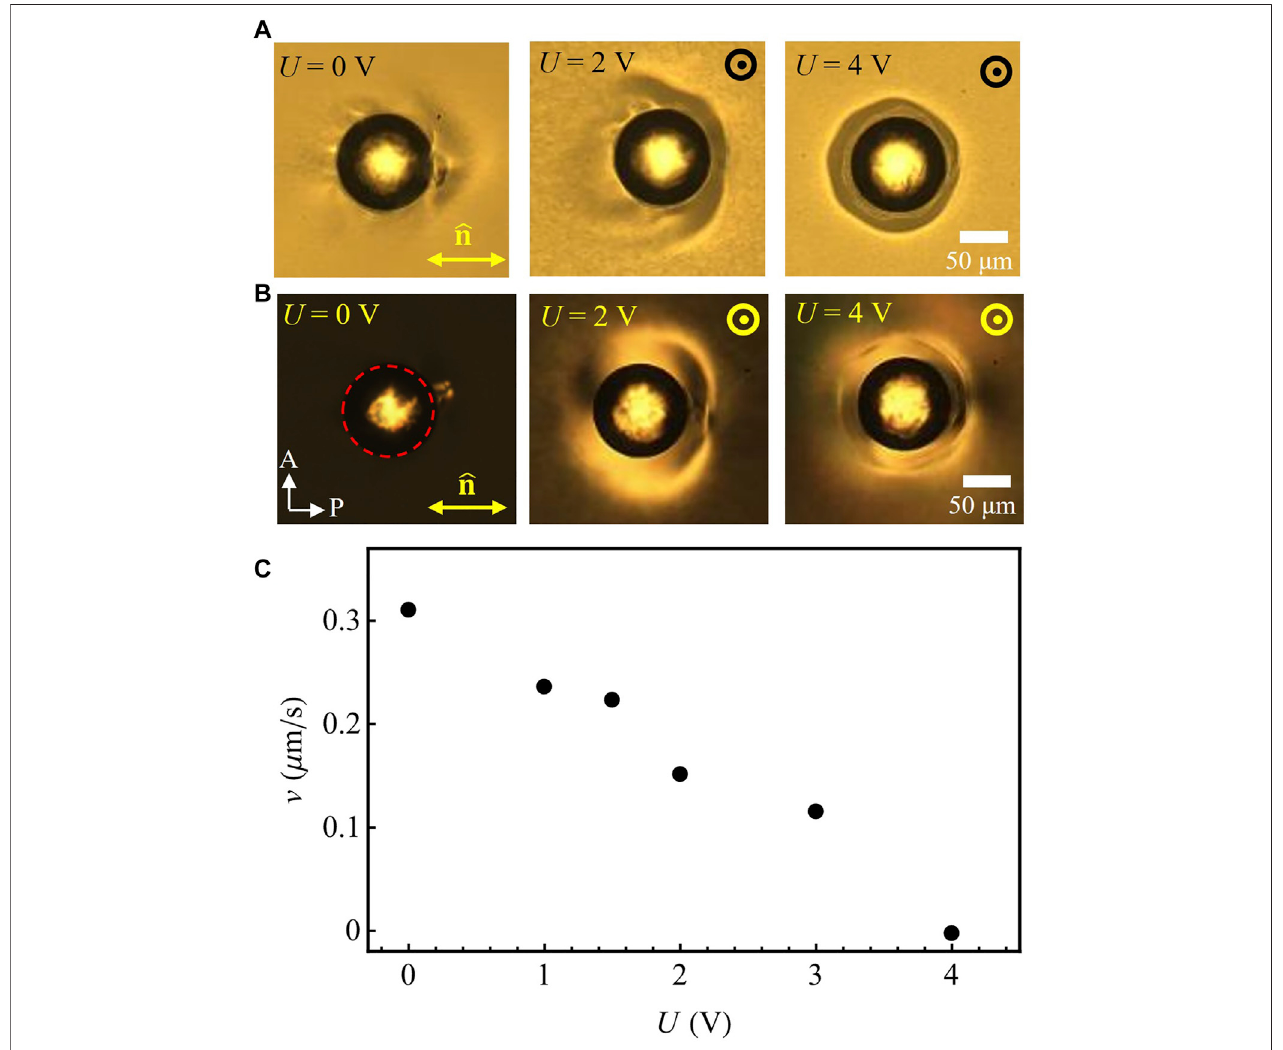
FIGURE 5| Polarizing microscopyobservations in (A) bright fi eld, and (B) with crossed polarizers ofactive droplets at different applied voltages. The fi eld direction is normal to the cell. f (cid:2) 200kHz. (C) The droplet speed as a function of the applied voltage.